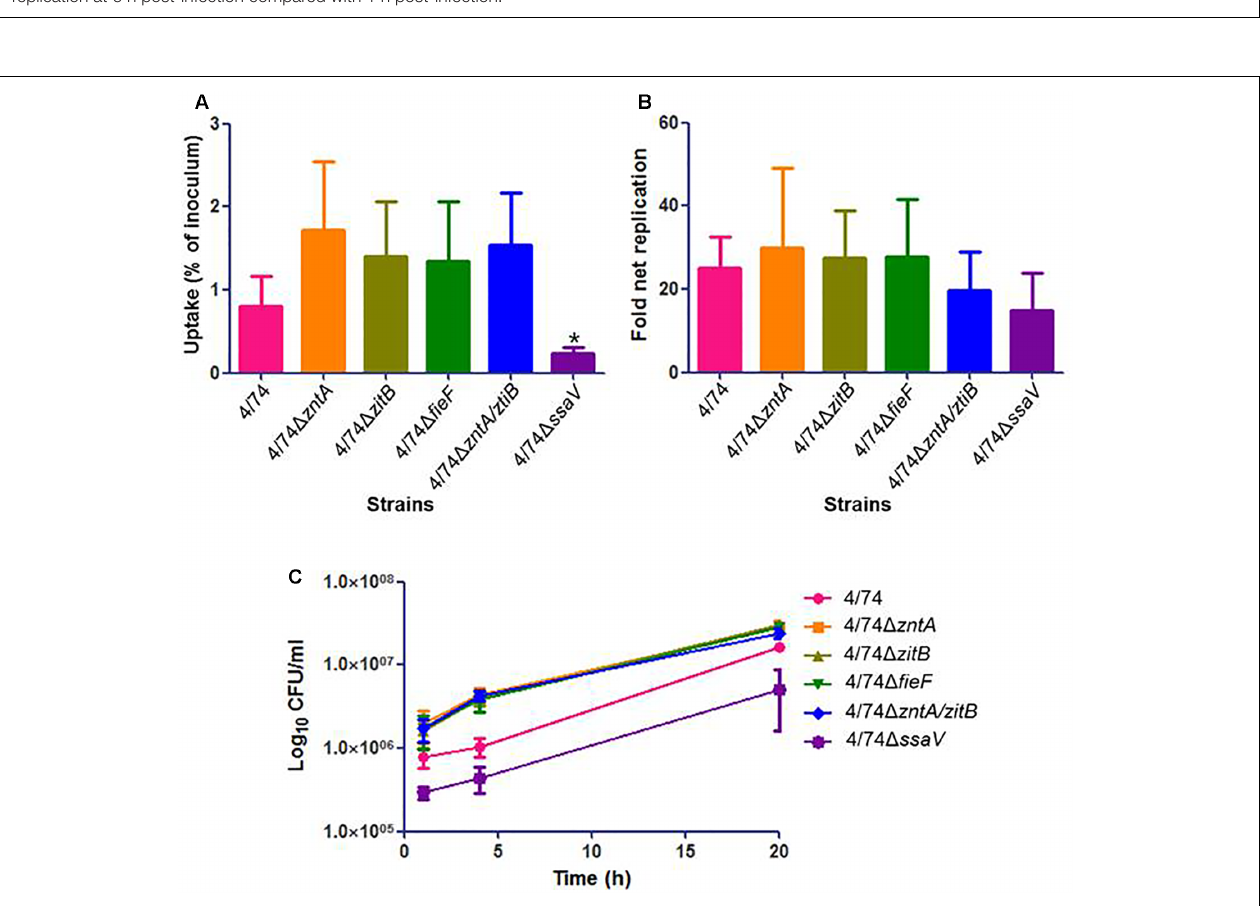
FIGURE 2 | Infection of amoebae with WT and zinc export mutants. (A) Uptake by amoebae (percentage of inoculated bacteria that are able to infect). (B) Fold net replication at t = 6 versus t = 1 h. No significant differences were observed between the WT and the mutants neither in percentage of uptake nor in fold net replication at 6 h post-infection compared with 1 h post-infection.